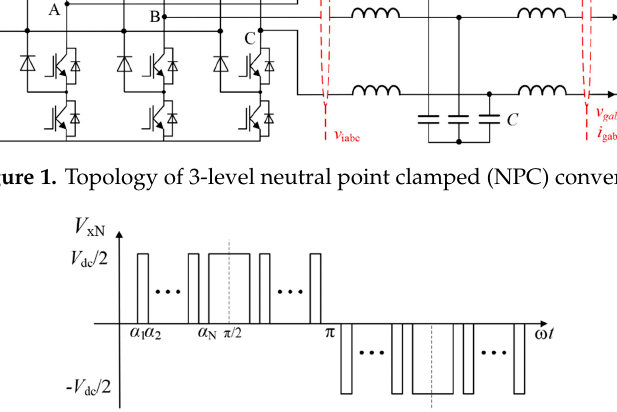
Figure 2. Selective harmonic elimination pulse width modulation (SHE-PWM) waveform.